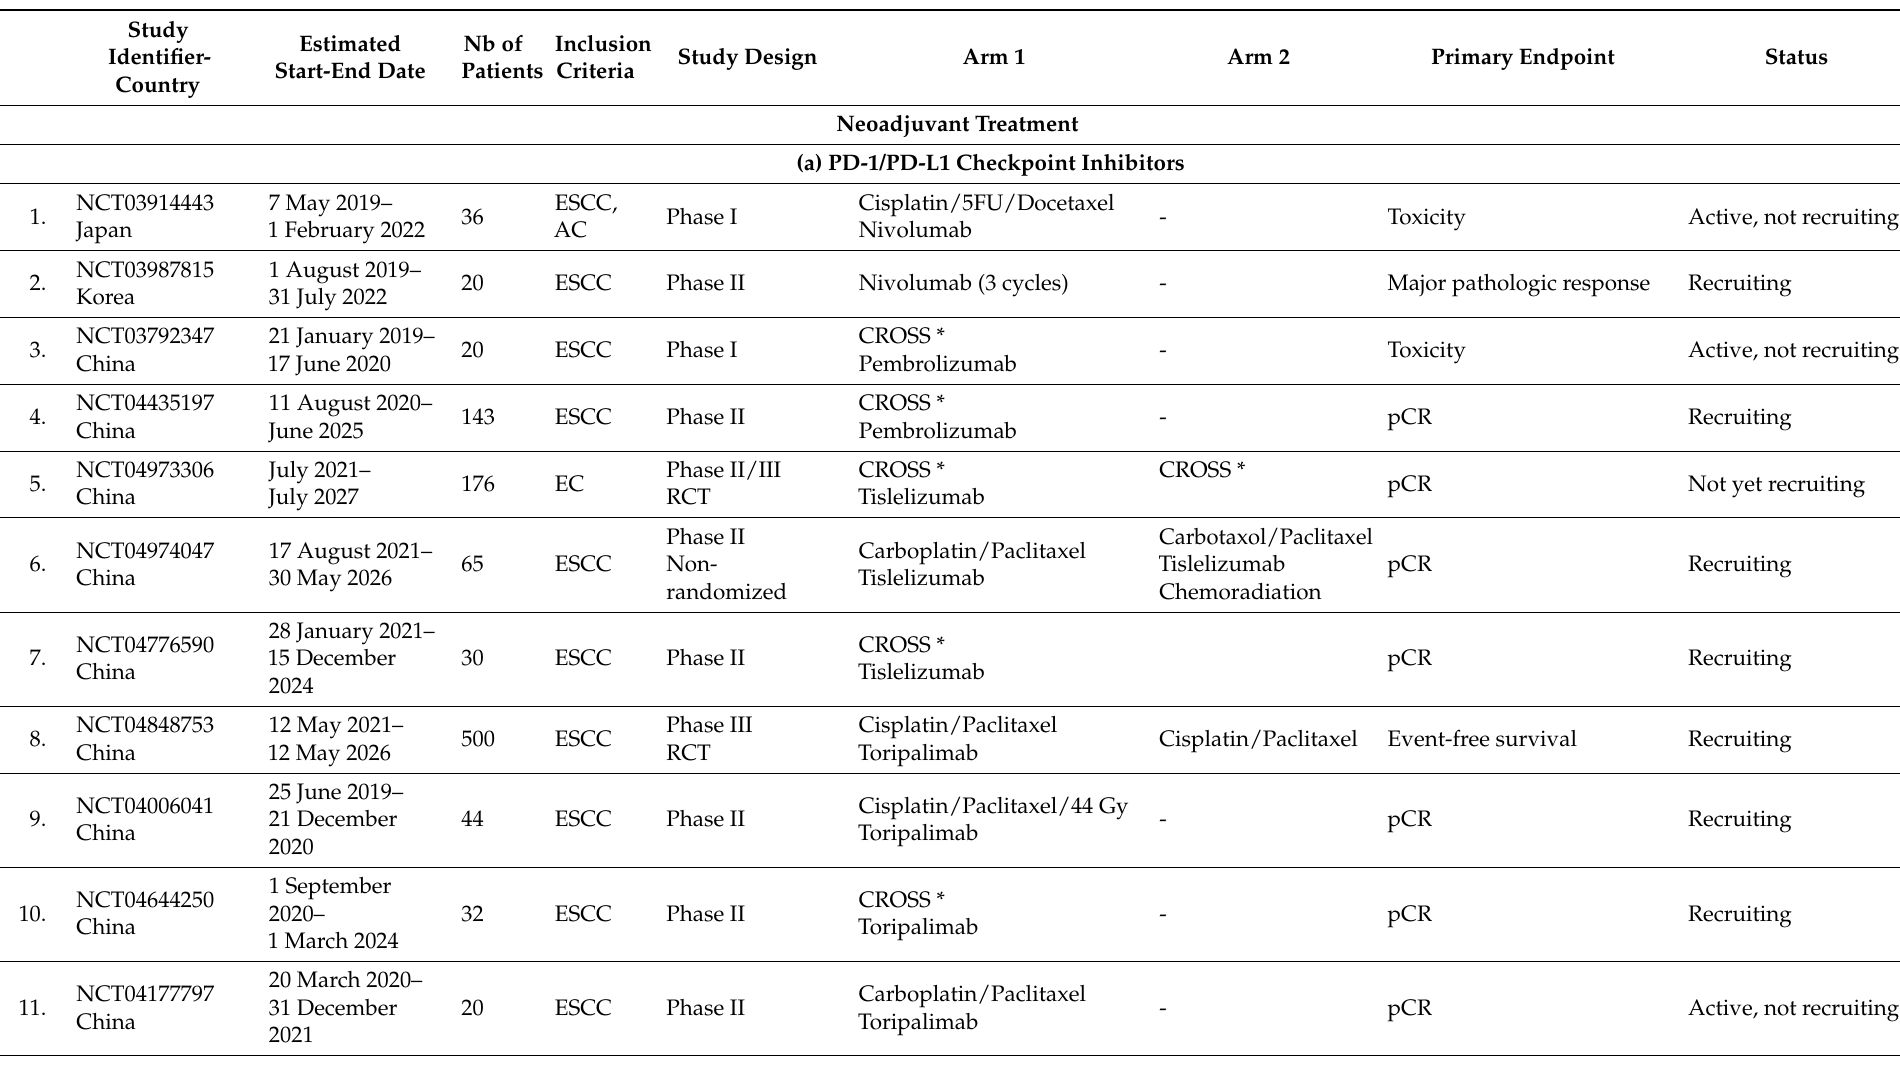
Table 2. Ongoing